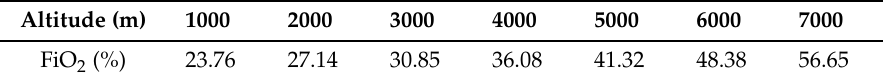
Table 5. FIO 2 required for maintaining sea-level PO 2 .